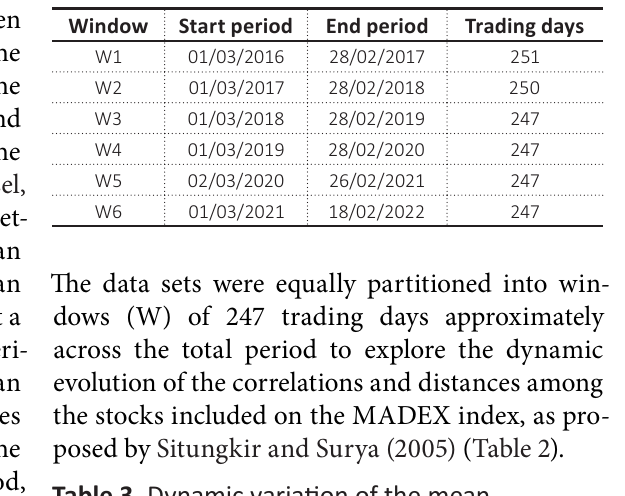
Table 2. Partition of the data sets into six windows